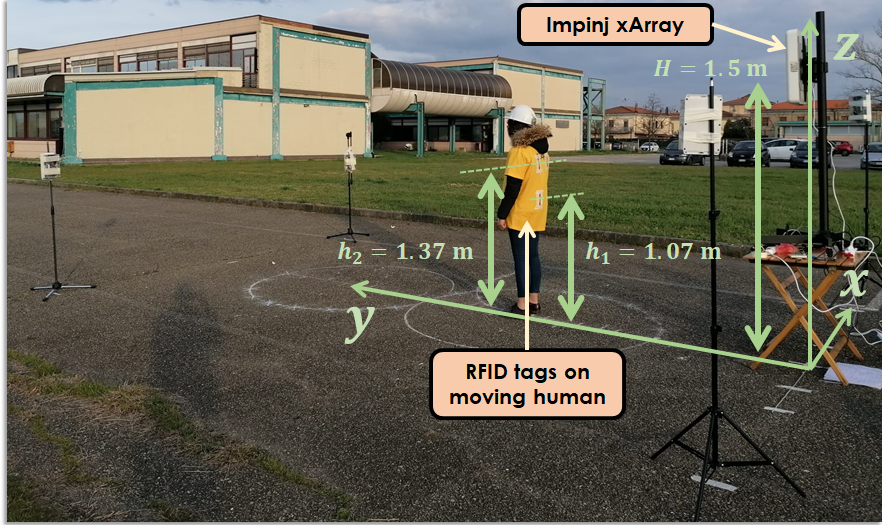
Figure 7. Measurement setup for the validation of the tracking